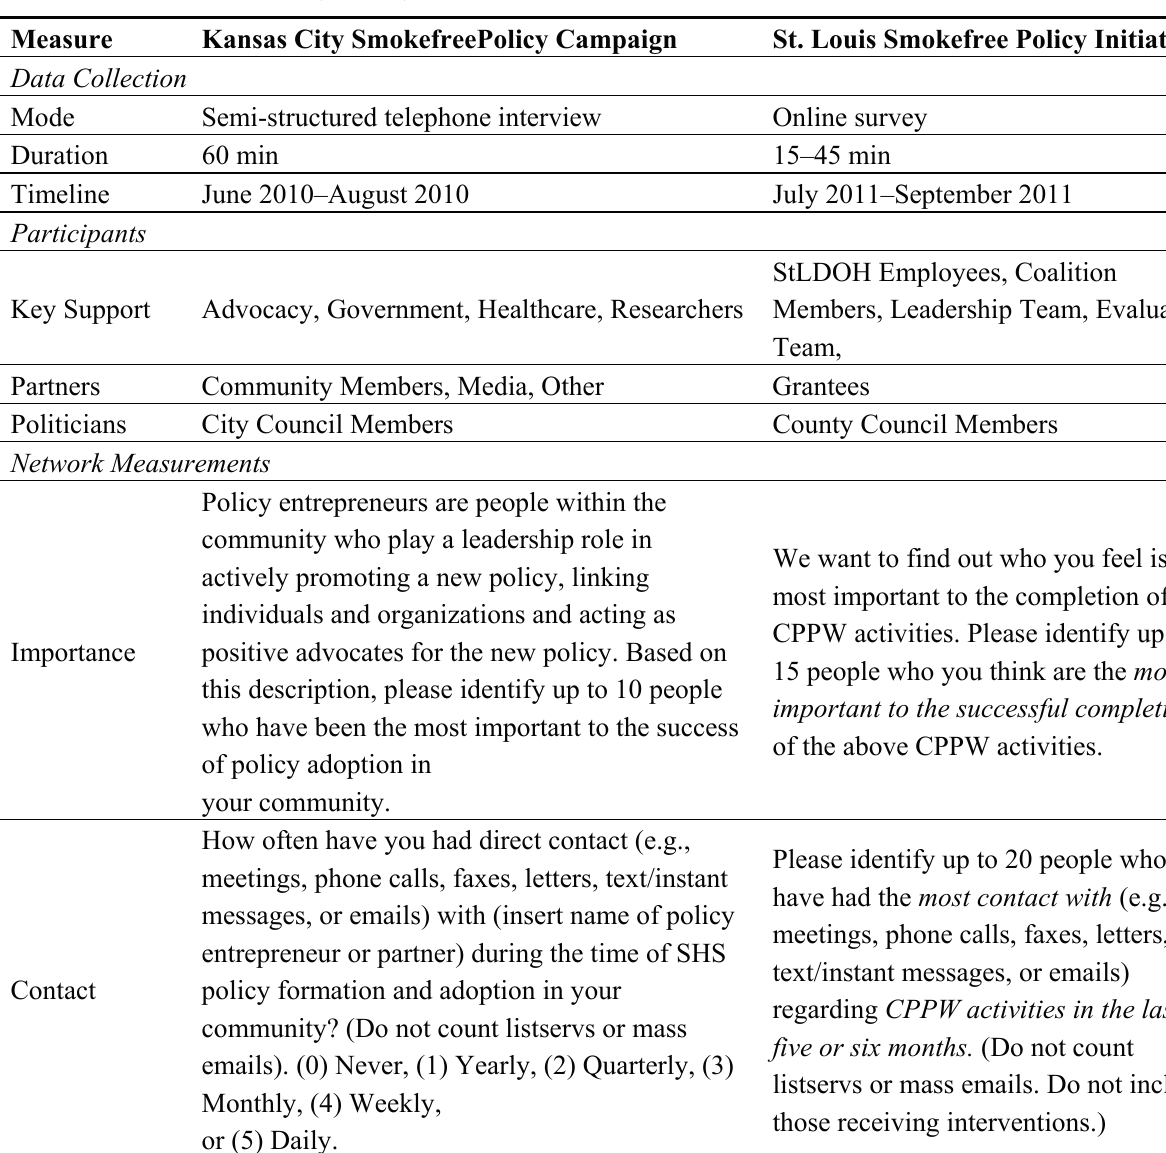
Table 1. Methods comparison for Kansas City and St. Louis Communities Putting Prevention to Work (CPPW)